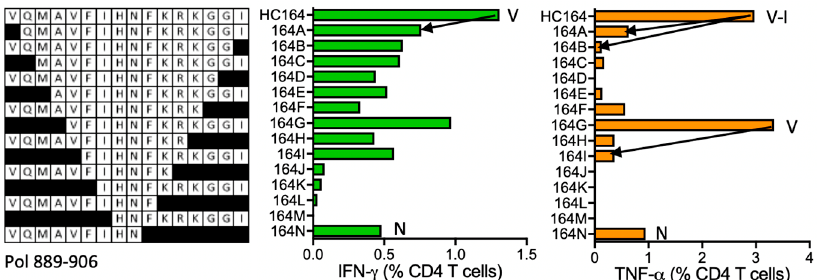
Figure 16. HC164/VID 404—definition of CD4 + T-cell epitopes in HIV-1 protein Pol. Subject 404 ′ s PBMCs were expanded in culture using HC164 stimulation and the resulting STCL was tested using shorter peptide derivatives (left) for IFN- γ (green) and TNF- α (orange) production. Arrows and amino acids V, N and I indicate the stimulatory peptide termini.